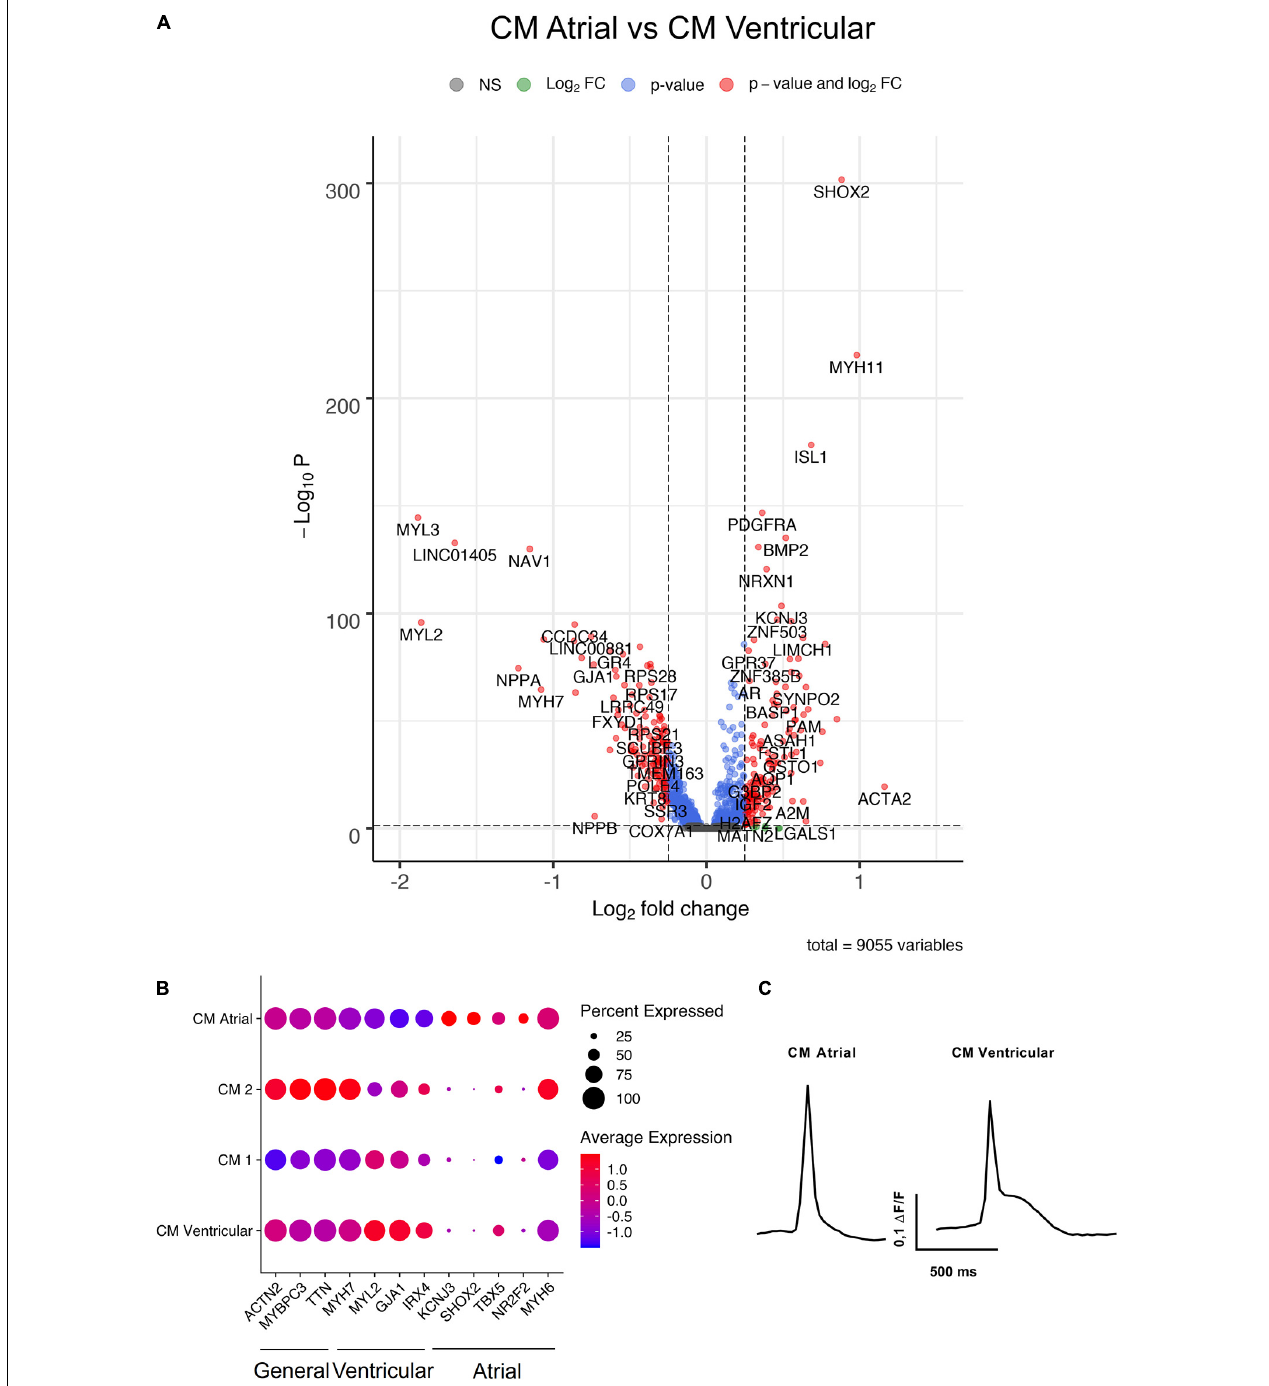
FIGURE 4 | Characterization of hiPS-CM clusters. (A) Volcano plot of altered genes in atrial type hiPS-CMs (CM Atrial-cluster) compared to ventricular type hiPS-CMs (CM Ventricular-cluster). (B) Expression of general CM genes, atrial CM, and ventricular CM genes in the four hiPS-CM clusters. (C) Representative action potential morphologies of atrial and ventricular hiPS-CMs. All scRNAseq data presented in the figure consists of combined data from HEL47.2 and HEL24.3 lines.